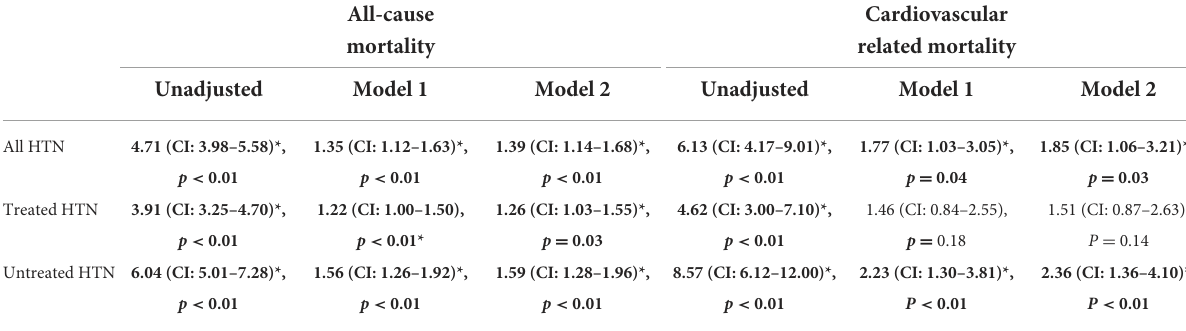
Theasterisksandboldvaluesindicatestatisticalsignificancevalues. HTN,Hypertension;CI,ConfidenceInterval;BMI,BodyMassIndex;FIBto4,Fibrosisto4Index.